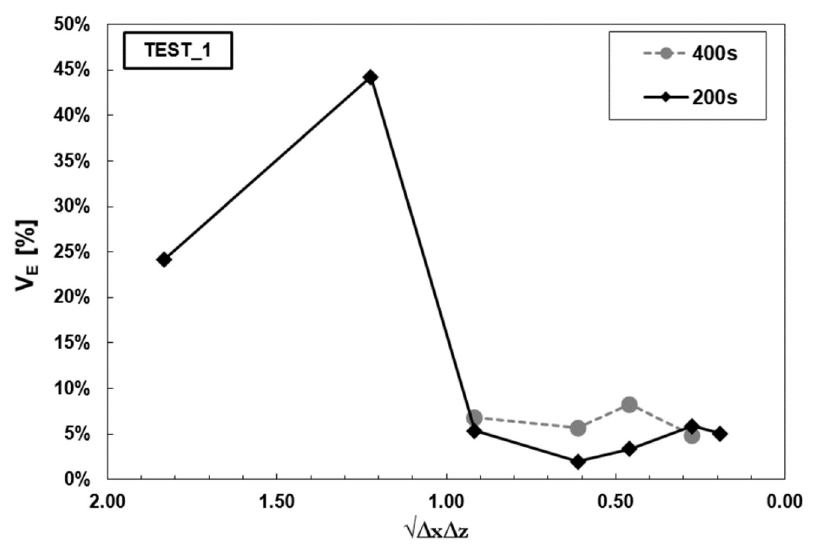
Figure 4. Relative volume error as a function of the geometric mean of two dimensions of the cell. TEST_1 (H = 8 m T = 10 s).